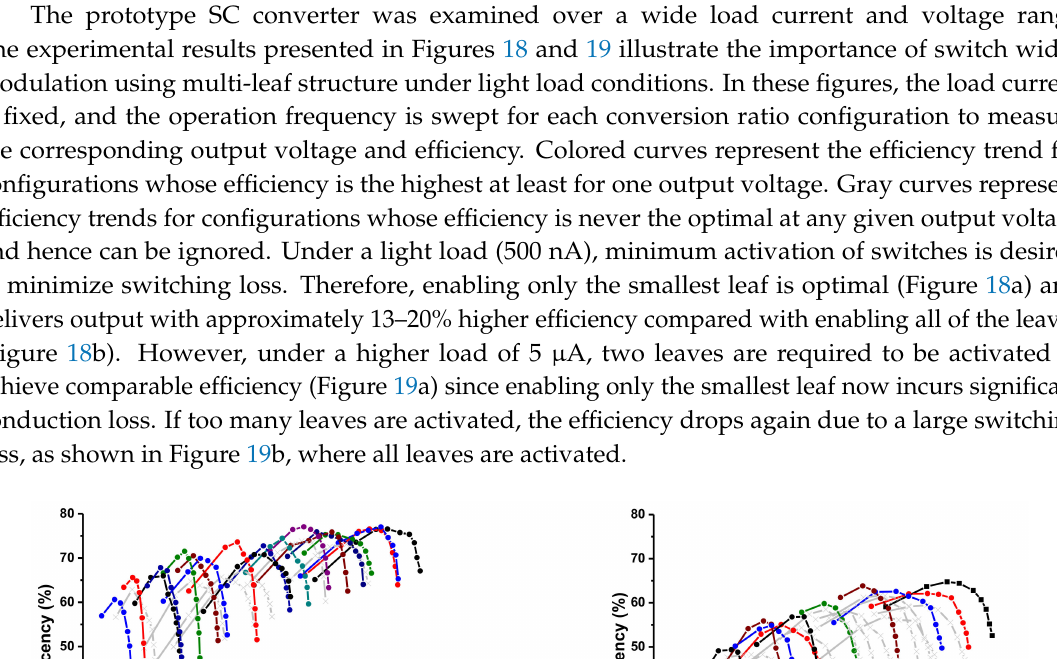
Figure 17. Chip micrograph.